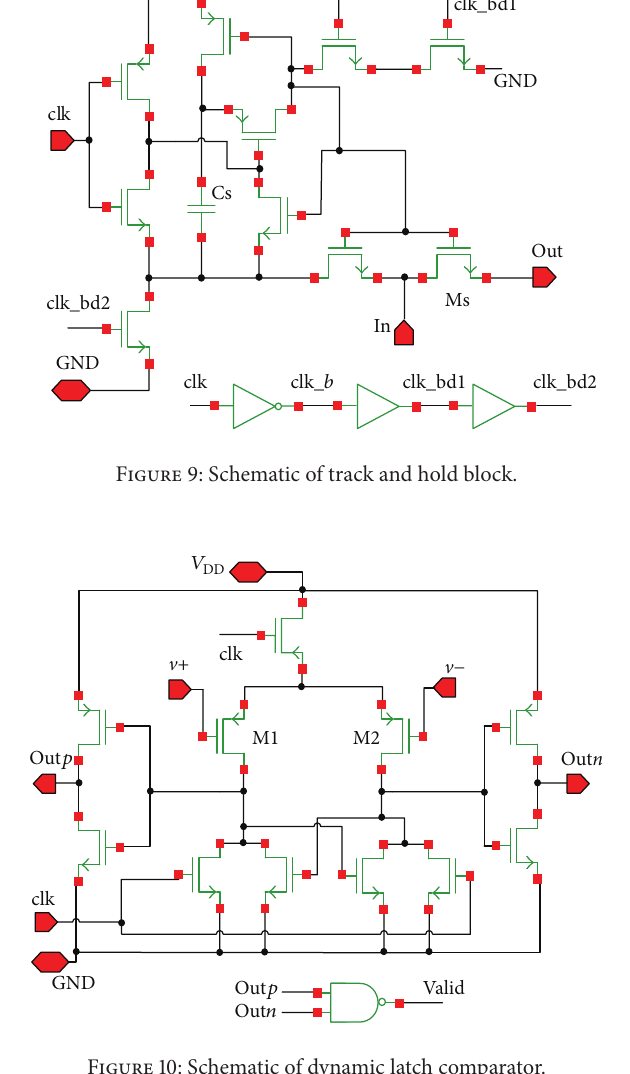
Figure 10: Schematic of dynamic latch comparator.